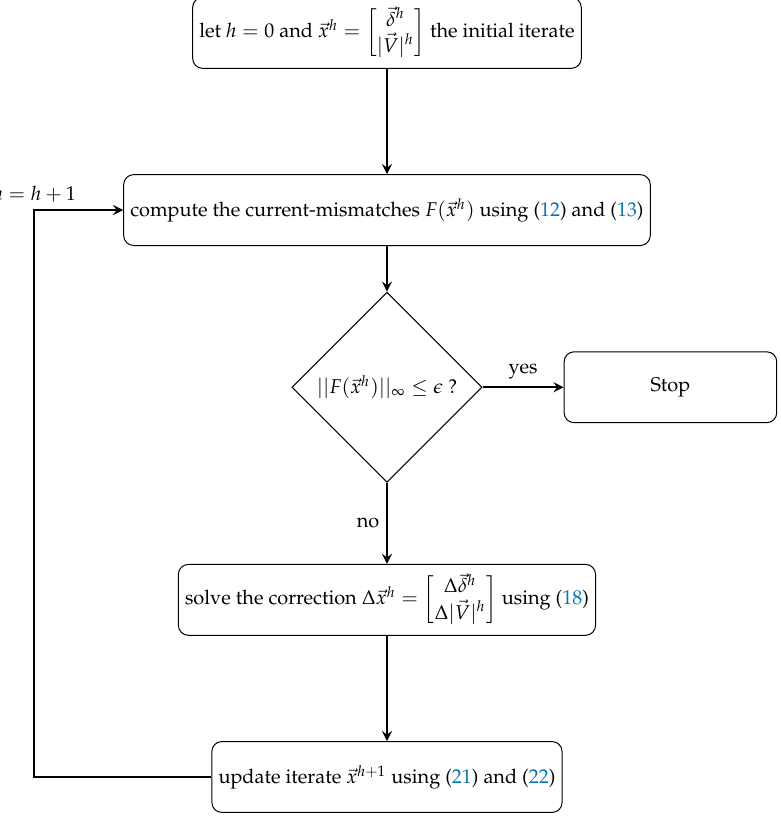
Figure 3. Flow chart of the polar current mismatch